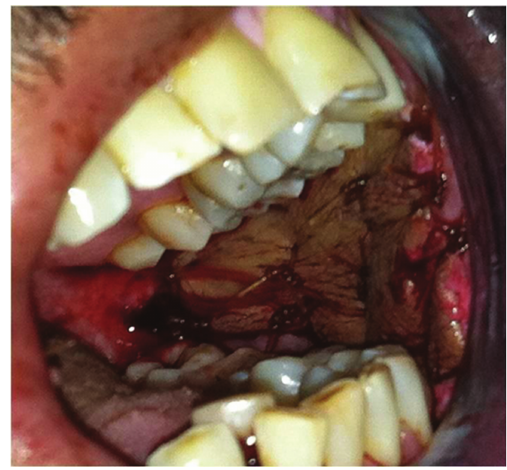
Figure 4: Intraoral views after suturing the graft to the buccal mucosa.